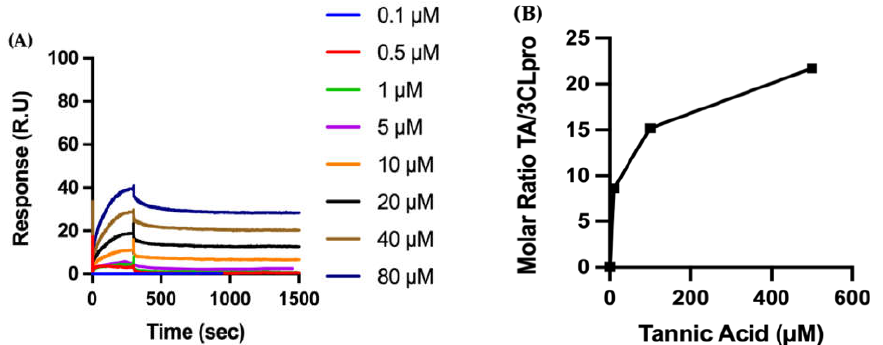
Figure 6. Biophysical characterization of the molecular interactions between the polyphenol TA on immobilized 3CLpro: ( A ) The recombinant protein 3CLpro is immobilized on a CM5 sensor chip, and increasing concentrations of TA are injected to evaluate binding kinetics by SPR. ( B ) 3CLpro is adsorbed to a gold QCMD sensor, and various concentrations of TA are flowed over the surface for 30 min. TA adsorption is expressed by the dimensionless molar ratio of adsorbed TA to adsorbed 3CLpro.